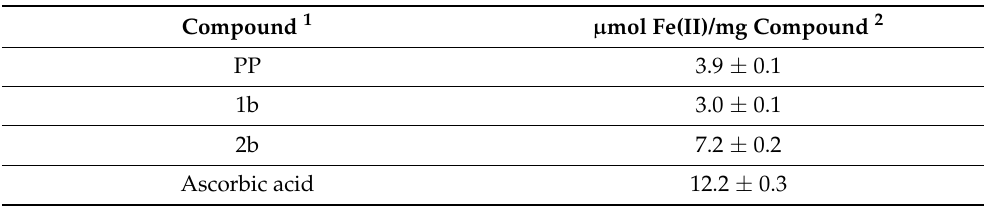
Table 3. Ferric-ion-reducing activities ofthe compounds under study. Measurements were performed in triplicate, and the data represent mean ±